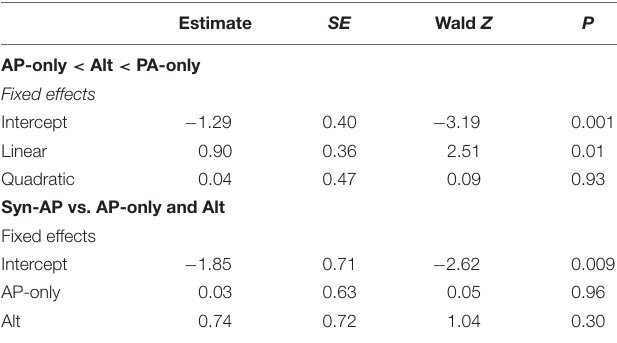
TABLE 2 | Mixed models of the likelihood of a PA order response in Experiment